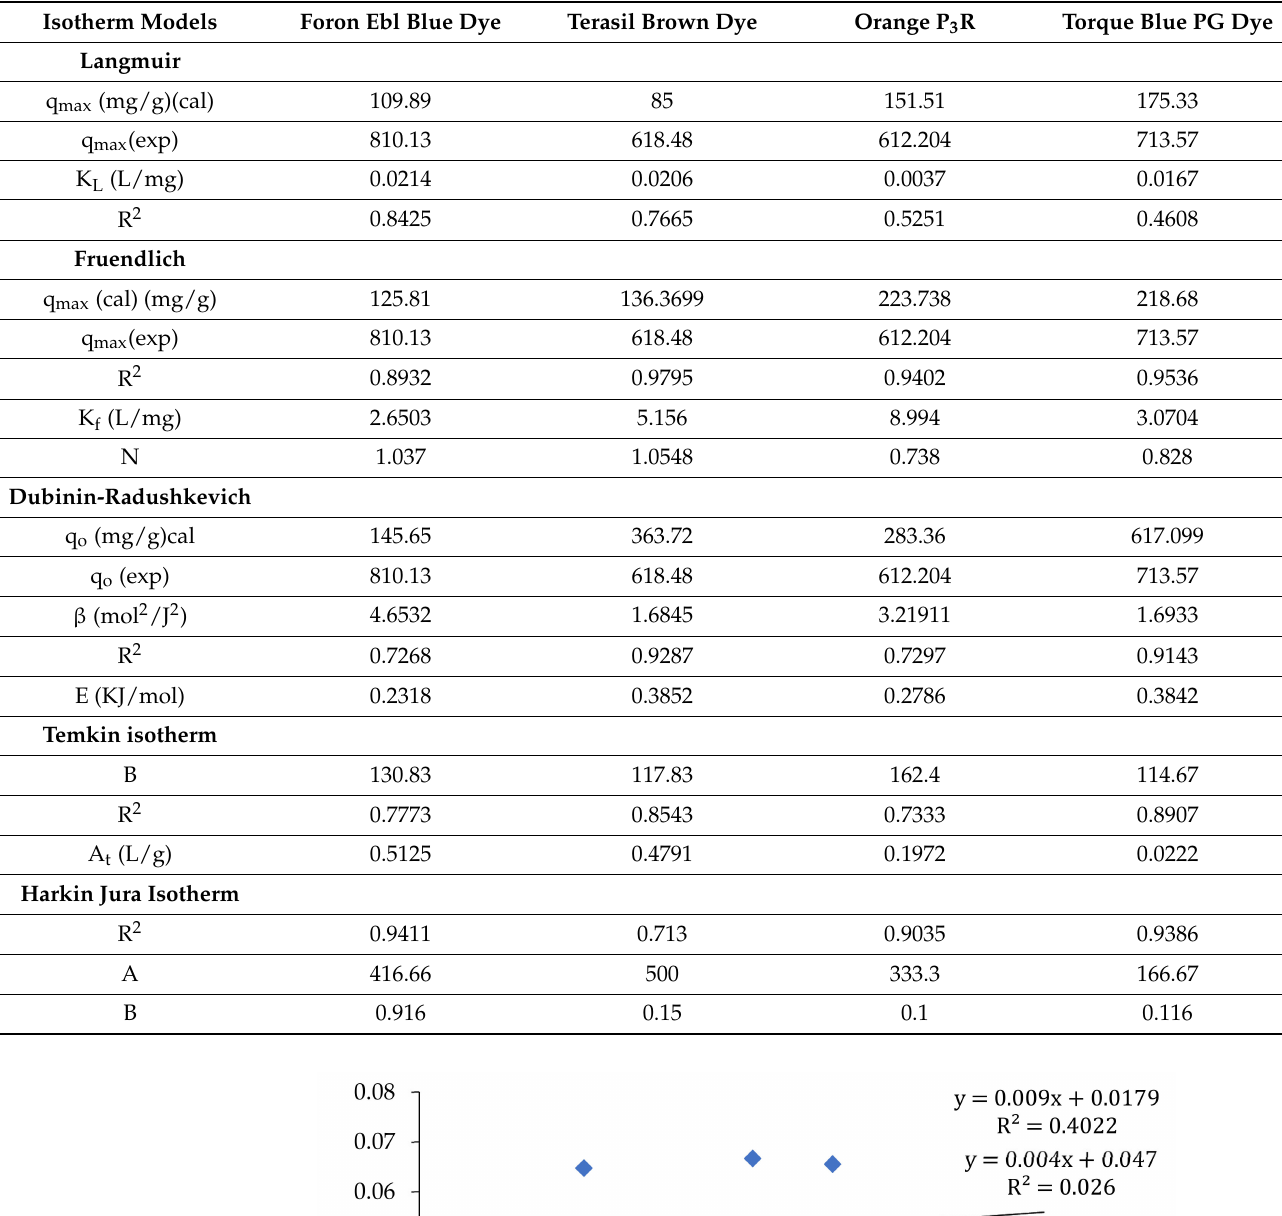
Table 2. Adsorption isotherm parameters for all four dyes by calcinized composite at five different concentrations (5, 10, 20, 25, and 50 ppm).